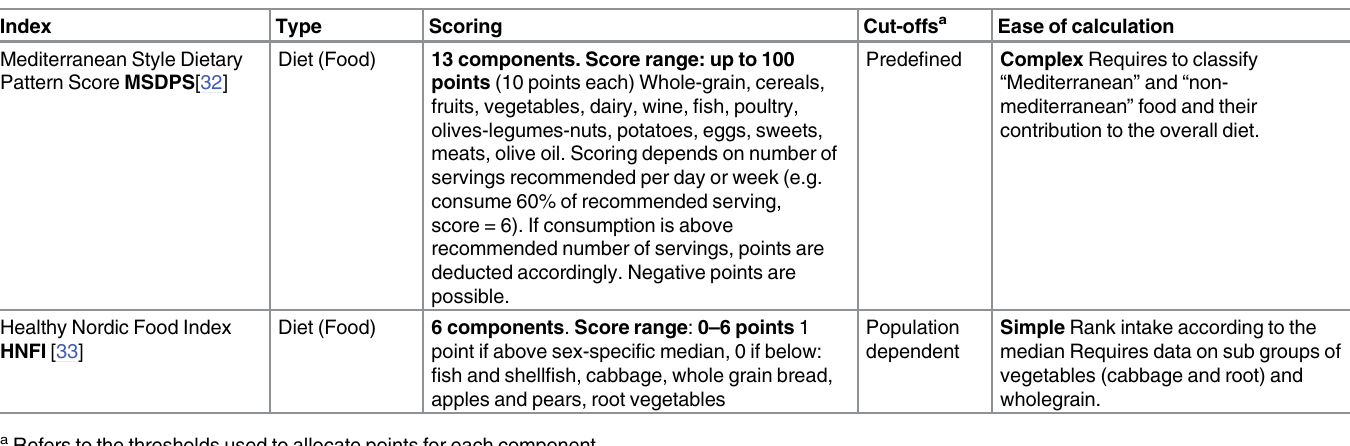
meats, olive oil. Scoring depends on number of servings recommended per day or week (e.g. consume 60% of recommended serving, score = 6). If consumption is above recommended number of servings, points are deducted accordingly. Negative points are possible.